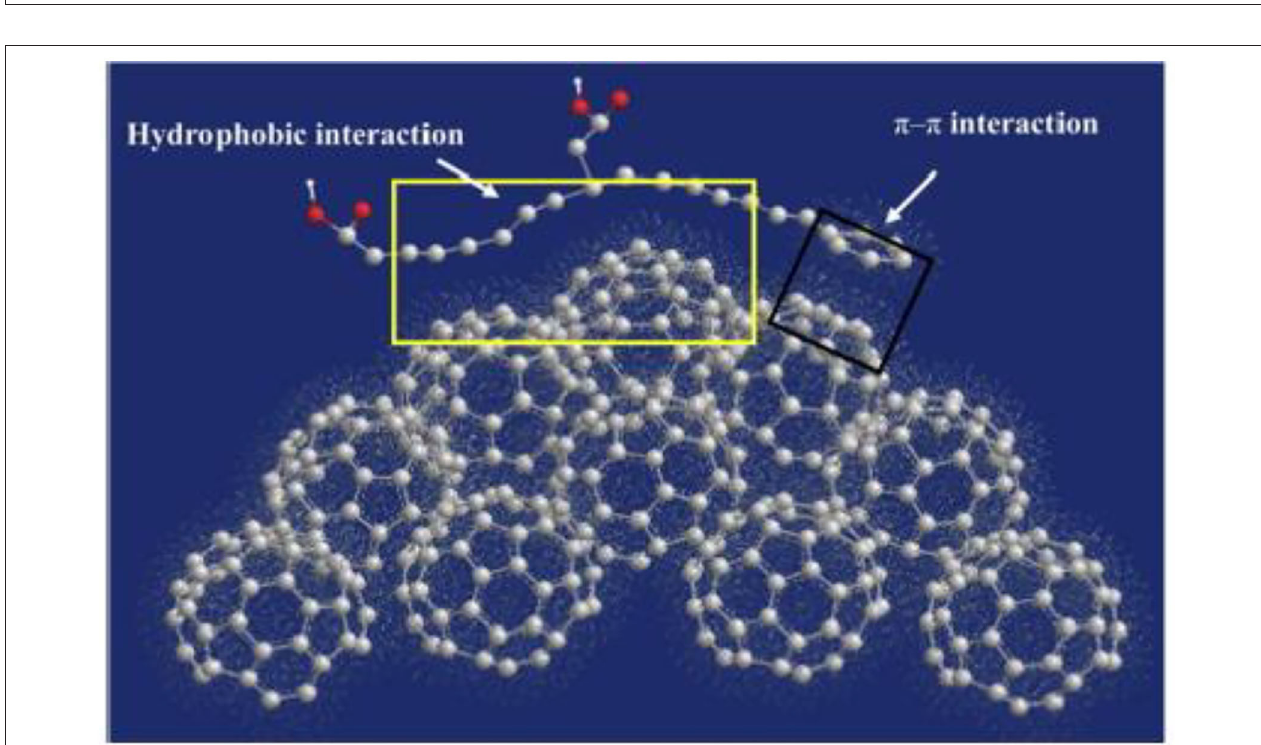
FIGURE 6 | Schulten DOM 3D model using the TNB (Temple–Northeastern–Birmingham) model (Orsi, 2014).